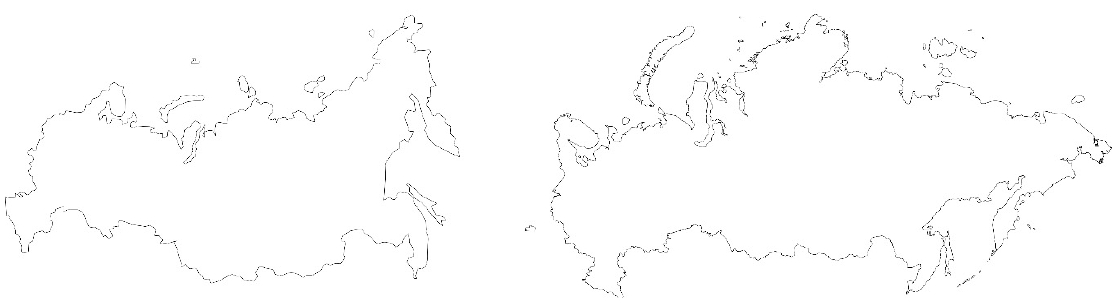
Figure 9. Russia represented with Mercator versus Lambert projection (with standard parallels at 15°N and 65°N).